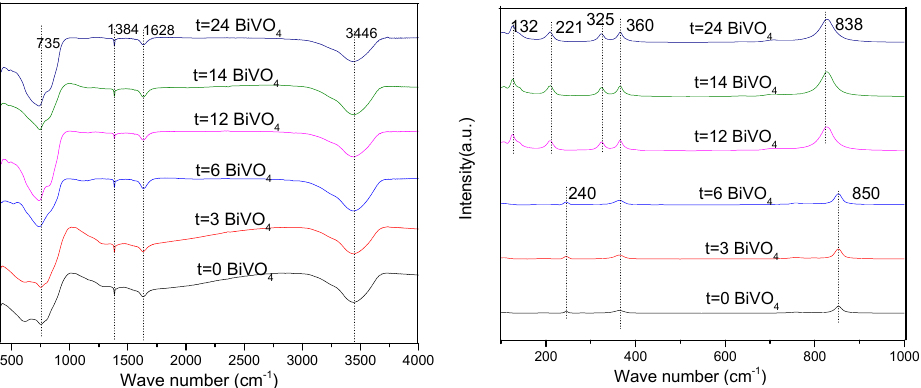
Figure 6. FTIR ( left ) and Raman spectra ( right ) of the BiVO 4 prepared with different hydrothermal times.